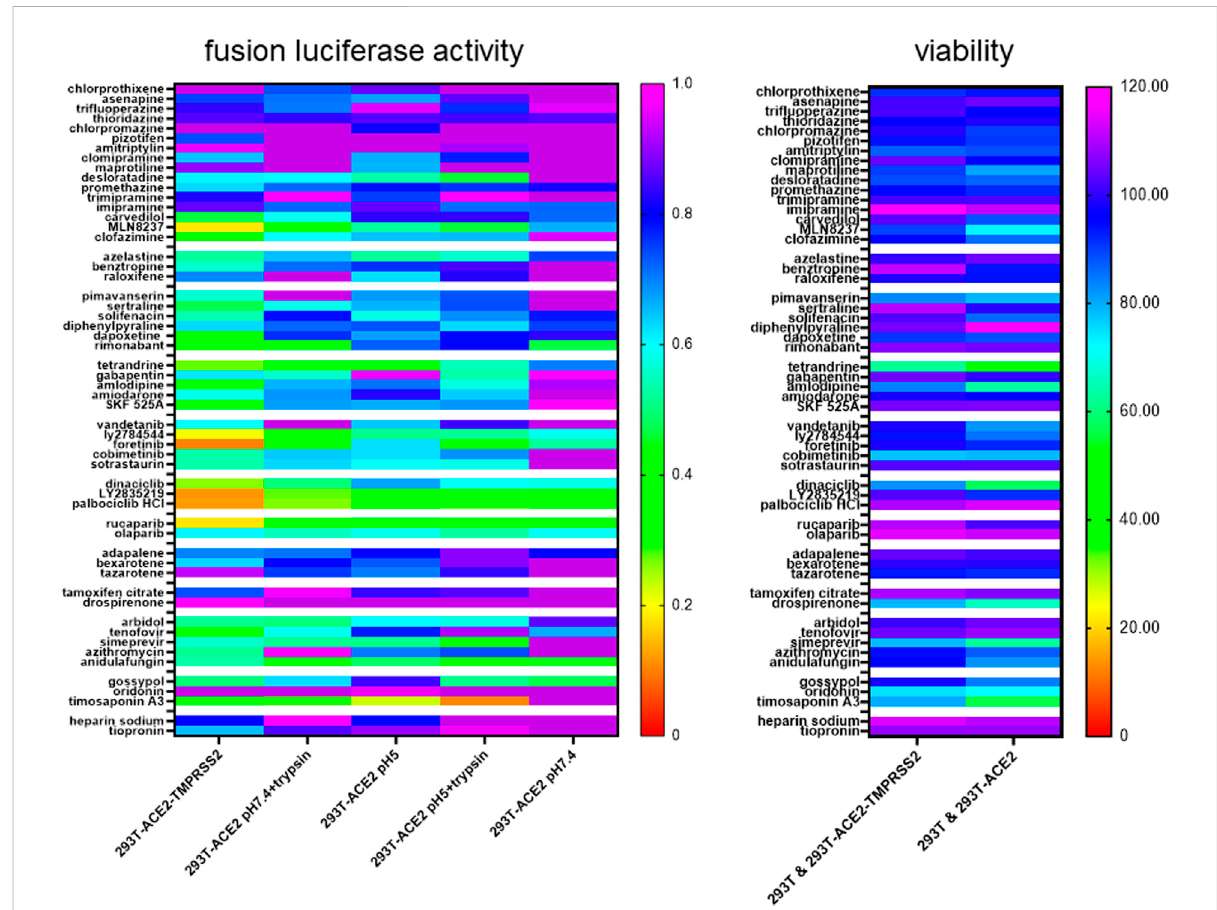
FIGURE 6 Heatmap of drug inhibition pro fi les of different modes of fusion. 19,000 target cells (293T-ACE2, 293T-ACE2-TMPRSS2) transfected with the luciferase and β -galactosidase reporter genes were pre-incubated with 10 μ M of individual drugs before co-cultured with 19,000 donor 293T cells transfected with the severe acute respiratory syndrome coronavirus 2 (SARS-CoV-2) spike proteins together with a plasmid encoding the T7 polymerase. The co-cultures were treated as indicated. Fusion activity was measured as luciferase activity normalized against β - galactosidase activity and expressed as a ratio to the solvent control in the respective cell type and fusion condition which is set as 1. Data are presented as mean of 3 repeats. Viability was measured by XTT assays in fusion cells (293T + 293T-ACE2 or 293T + 293T-ACE2-TMPRSS2) under physiological pH and expressed as % viability to solvent control which is set as 100%. Data are presented as mean of three repeats. Data outside the range are depicted as dark